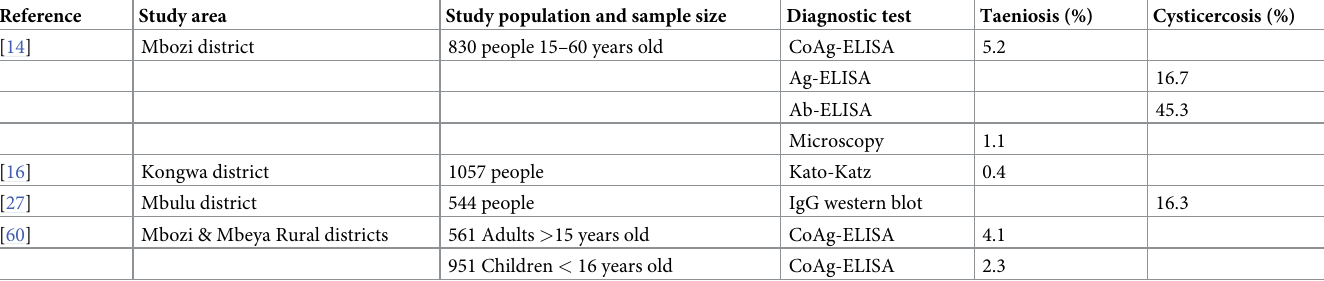
Table 1. Prevalence of human Taenia solium taeniosis/cysticercosis in the general populations in Tanzania from 1995–2018.